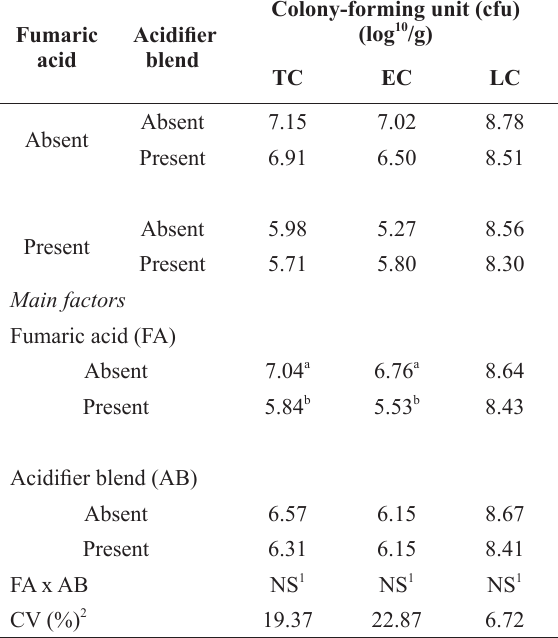
Mean cfu-values of piglet’s cecum